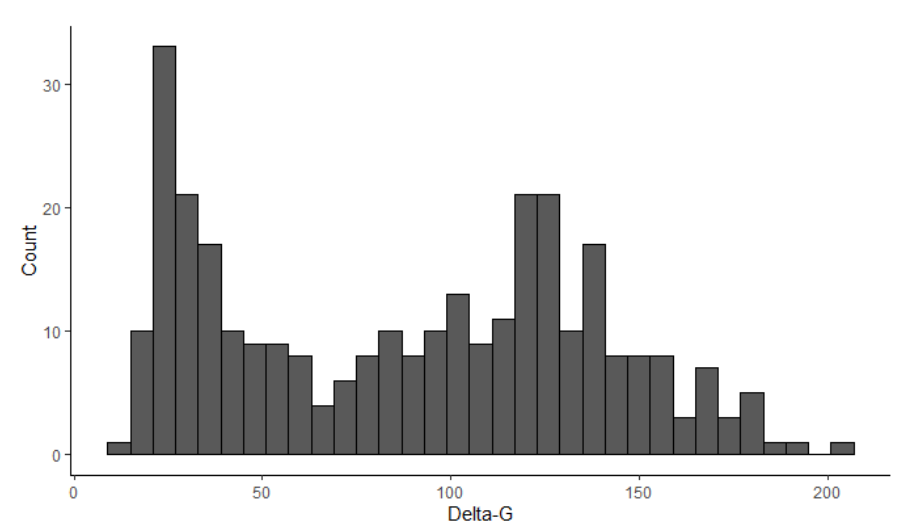
Figure 3. Distribution of 311 delta-G values recorded with a collar-mounted accelerometer for 10 s intervals of seven dogs at different speeds on a treadmill (mean: 88.70, median: 94.59, min: 14.23, max: 205.00, range: 190.77, LQ: 37.39, UQ: 126.89, IQR: 89.5).